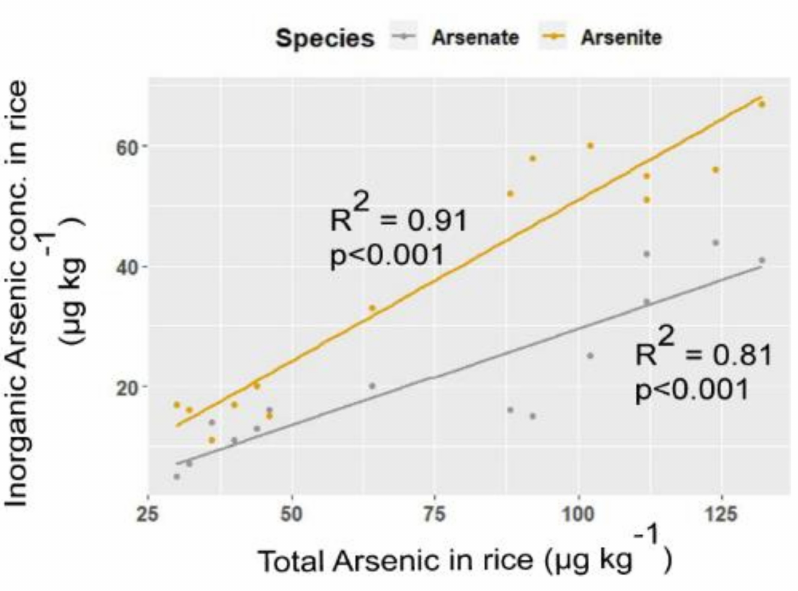
Figure 4. Correlations between total As concentration and inorganic As species in rice